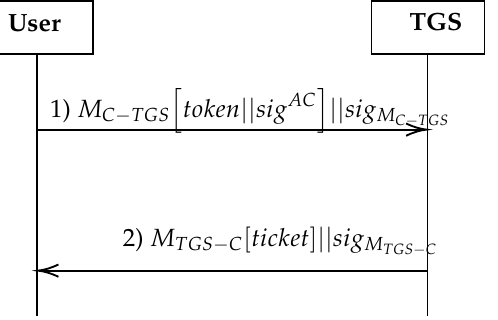
Figure 4. Sequence diagram for communication between the user and